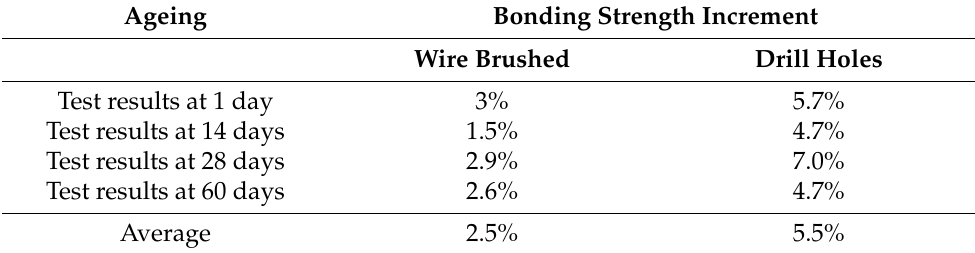
Table 4. The relative increase in slant-shear strength for wire brushed and drilled holes surface